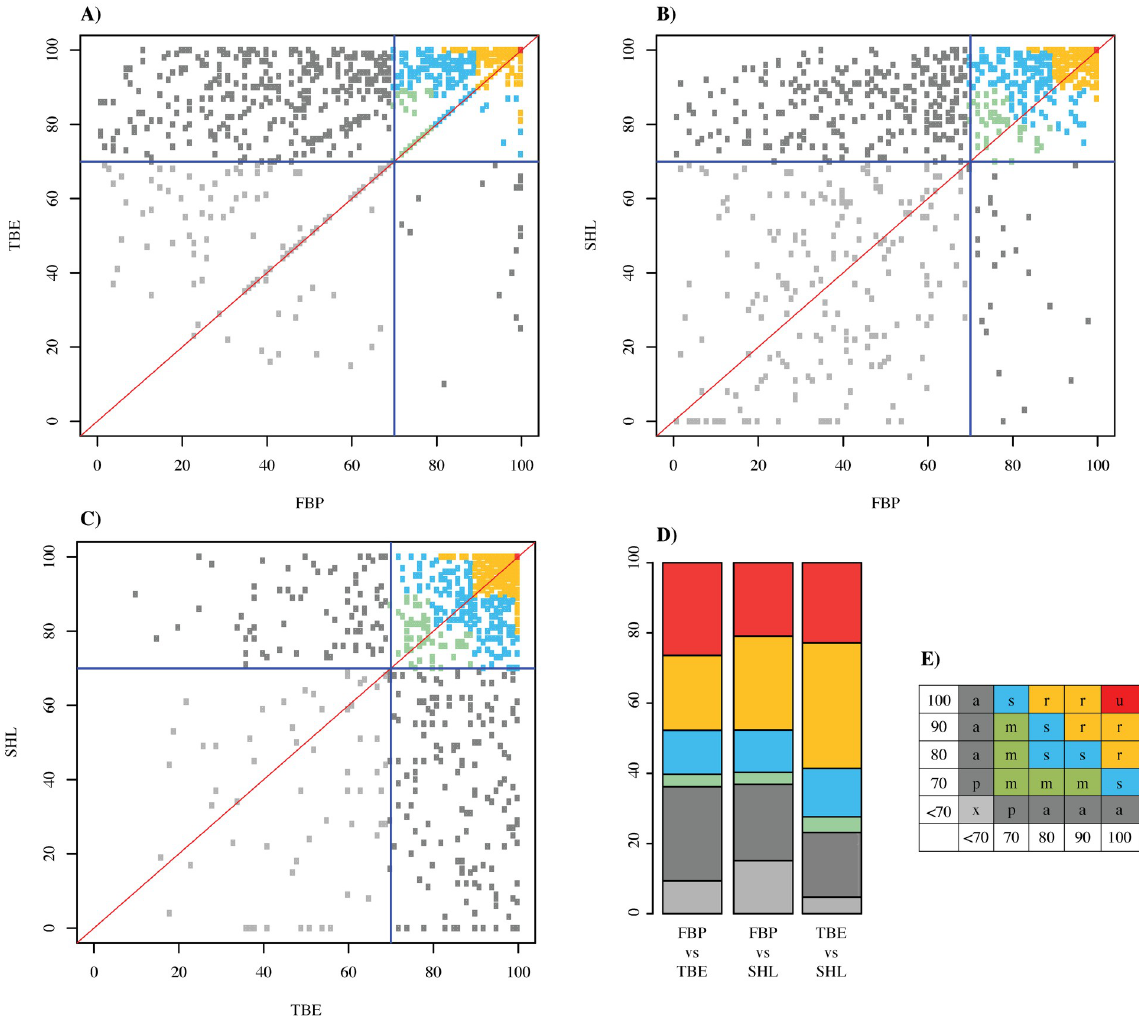
Fig 4. Scatterplots comparing support metrics for internal branches in the Maximum likelihood species-level phylogeny of Colubroides. A) TBE and FBP B) SHL and FBP C) SHL and TBE, D) Histogram showing the proportion of each category of joint support in each comparison of support metrics, E) Categories of joint